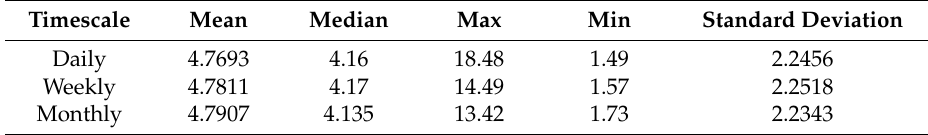
Table 1. Summary of descriptive statistics of natural gas spot price series for different